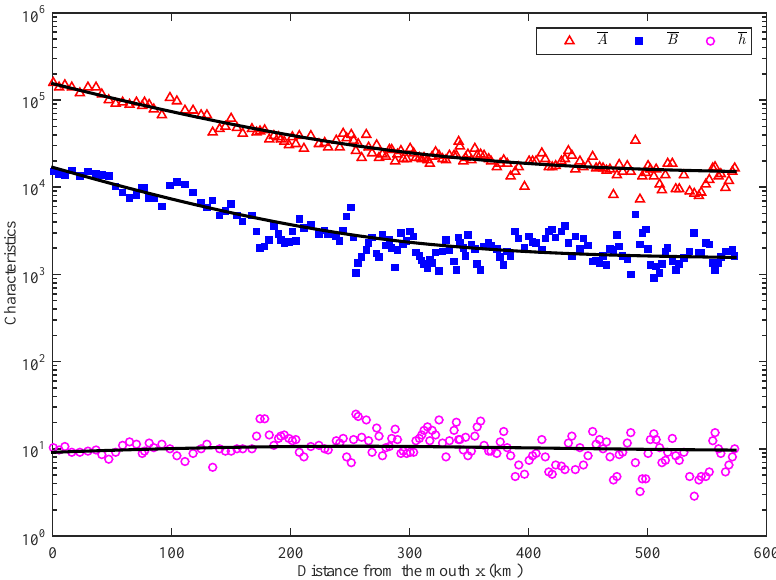
Figure 7. Semi-logarithmic plot of the geometric characteristics (the cross-sectional area A (m 2 ), width B (m), and depth h (m)) along the Yangtze estuary. The drawn lines represent the best-fitting